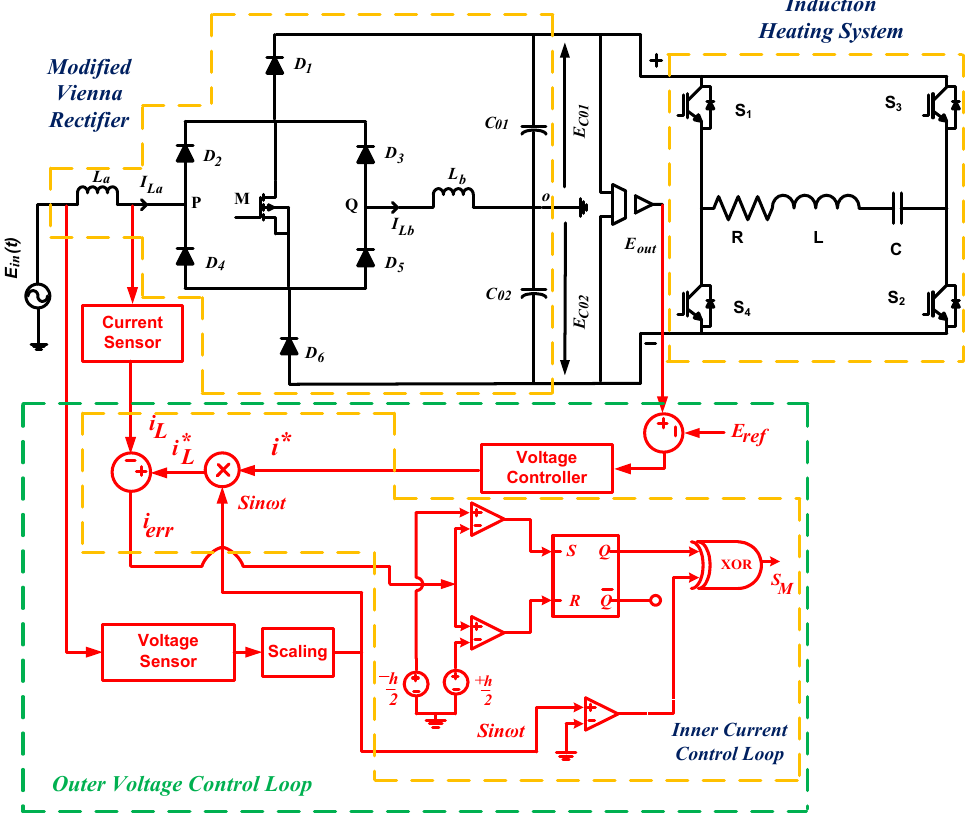
Figure 1. Proposed MVR-based induction heating system.